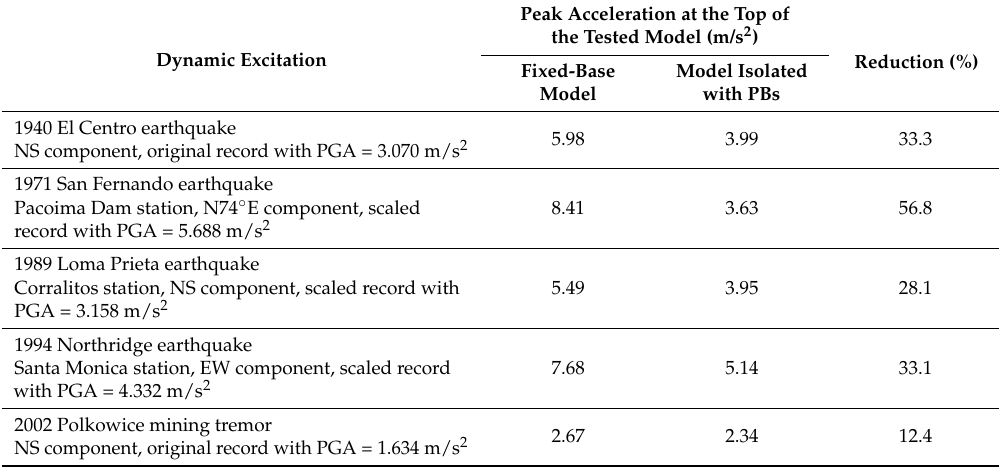
Table 2. Results of the seismic tests for the two-storey structure model.